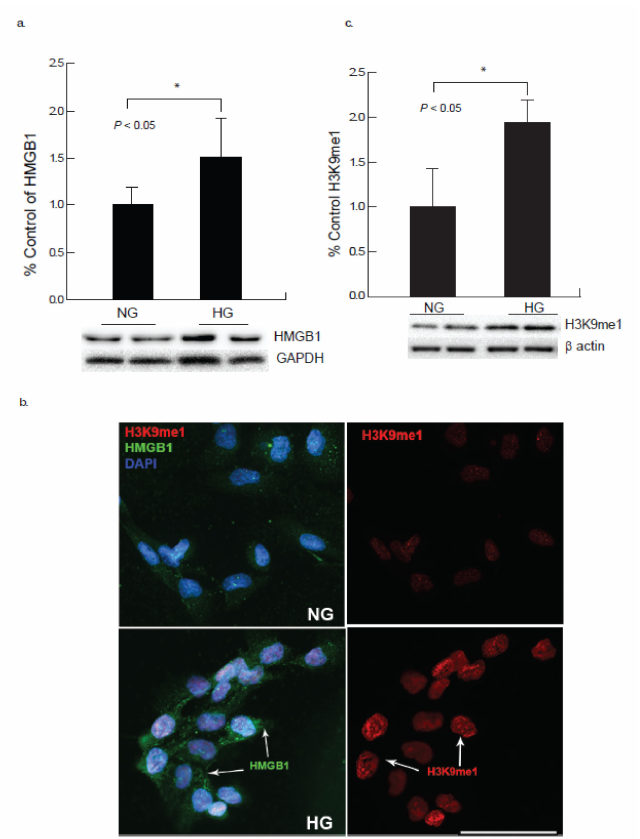
Figure 4. Hyperglycemia induces elevated expression of HMGB1 and H3K9me1 in